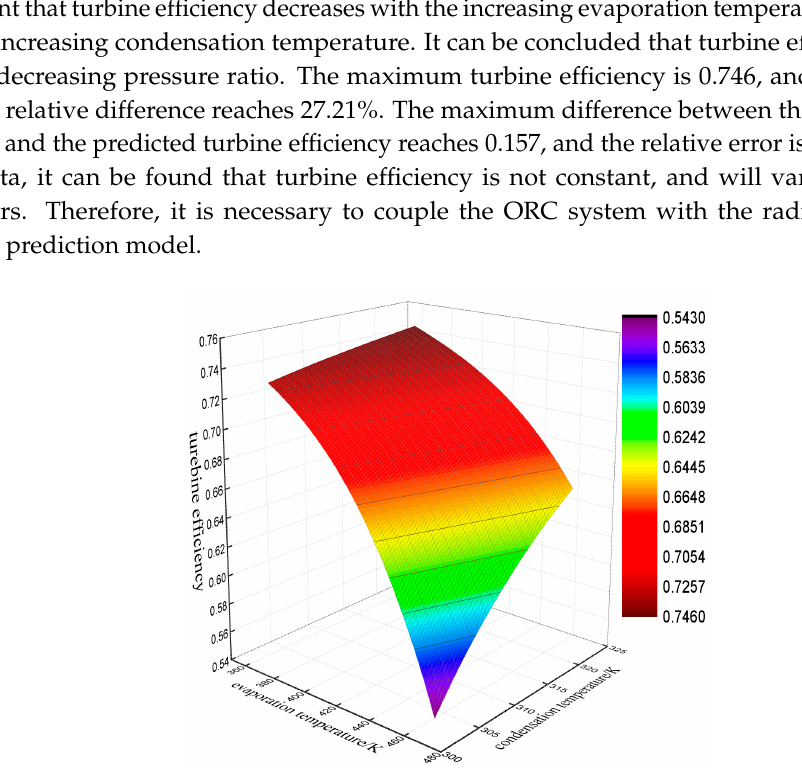
Figure 7. Radial-inflow turbine efficiency at different evaporation and condensation temperature.